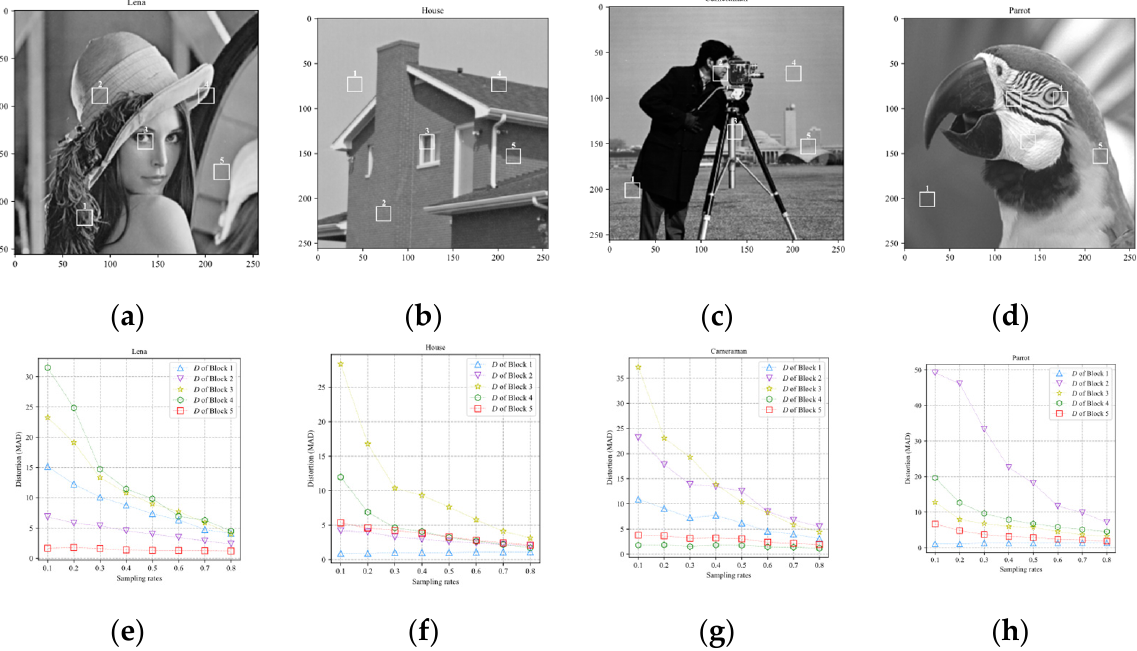
Figure 2. The MAD curves of different blocks: ( a ) Lena; ( b ) House; ( c ) Cameraman; ( d ) Parrot. ( e ) The MAD curves of five image blocks in Lena. ( f ) The MAD curves of five image blocks in House. ( g ) The MAD curves of five image blocks in Cameraman. ( h ) The MAD curves of five image blocks in Parrot. In addition, the block distortion curve is related to the content of the image